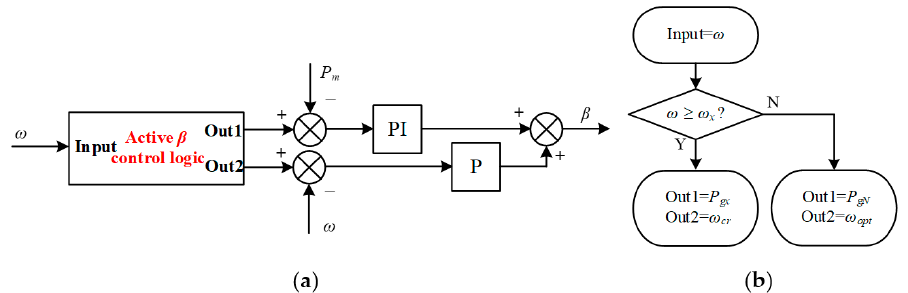
Figure 8. The active β coordinate control strategy and the control logic. ( a ) The pitch angle control in the active β control strategy. ( b ) The active β coordinate control logic.